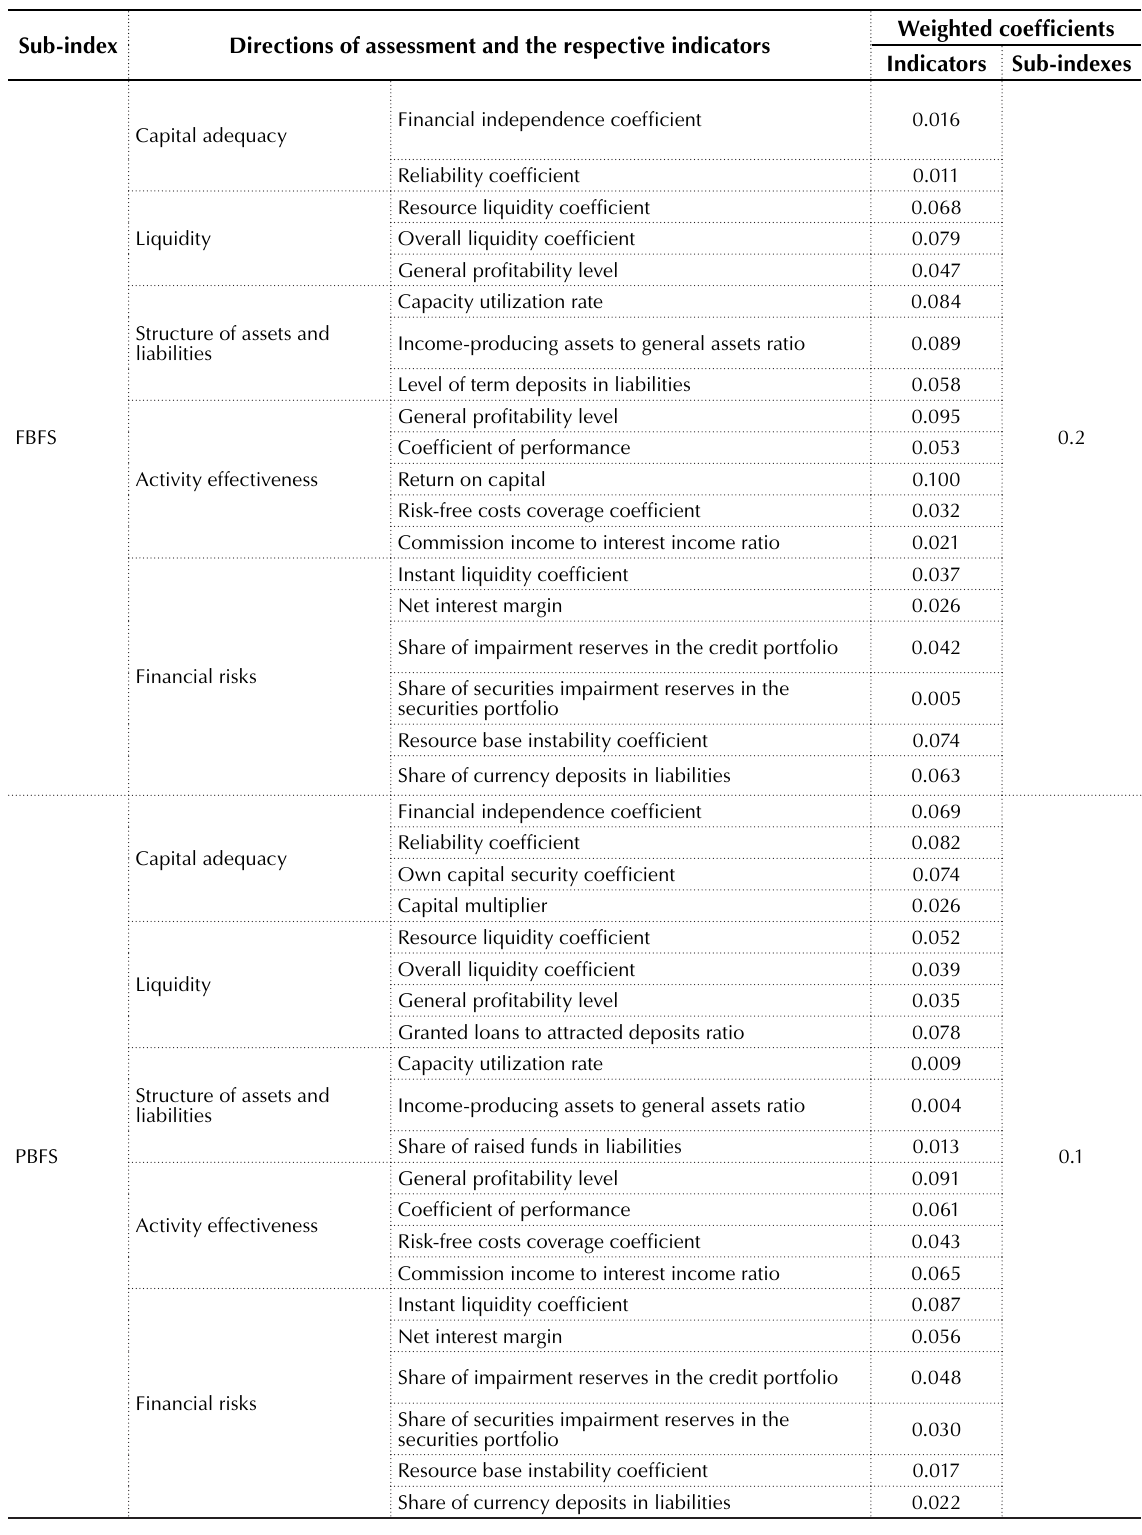
Table 3 (cont.). Information support of the banking system financial stability integral assessment according to the differential